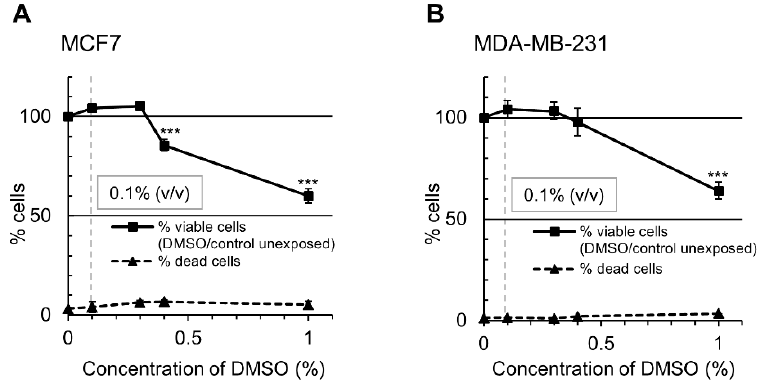
Figure 8. Effect of DMSO on MCF7 ( A ) and MDA-MB-231 ( B ) cell viability as measured by trypan blue exclusion test. MCF7 and MDA-MB-231 breast cancer cells were incubated for 4 days with DMSO at the indicated concentrations. The number of viable cells after 4 days exposure to DMSO was expressed as a percentage of viable cells in the unexposed control ((viable DMSO/viable unexposed control)*100%). The number of dead cells in either unexposed control or DMSO-exposed group was calculated as a percentage of the total cell number. DMSO at 0.1% ( v / v ) concentration was used as a vehicle control in all experiments. Values are means ± SD of at least three independent experiments. DMSO versus unexposed control, *** p < 0.001.